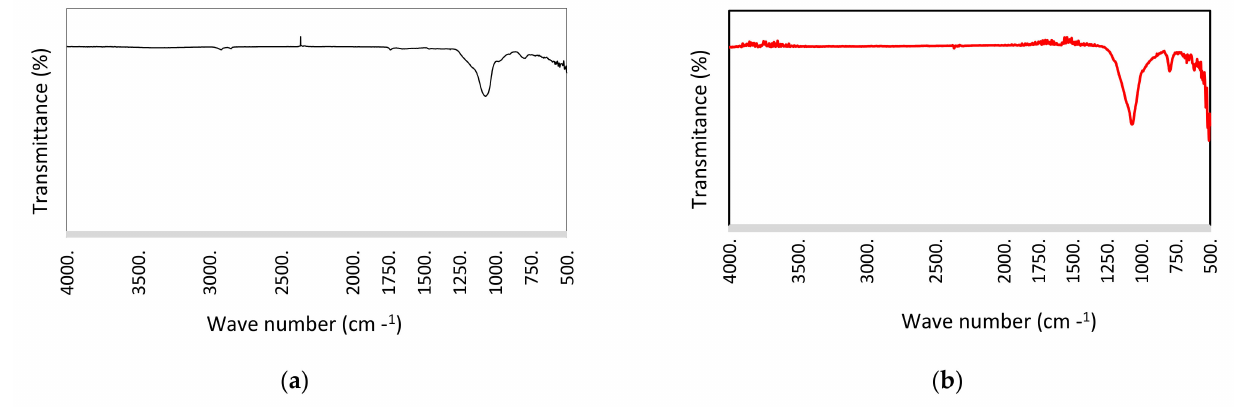
Figure 2. FTIR spectra of ( a ) raw WS ( b ) WS